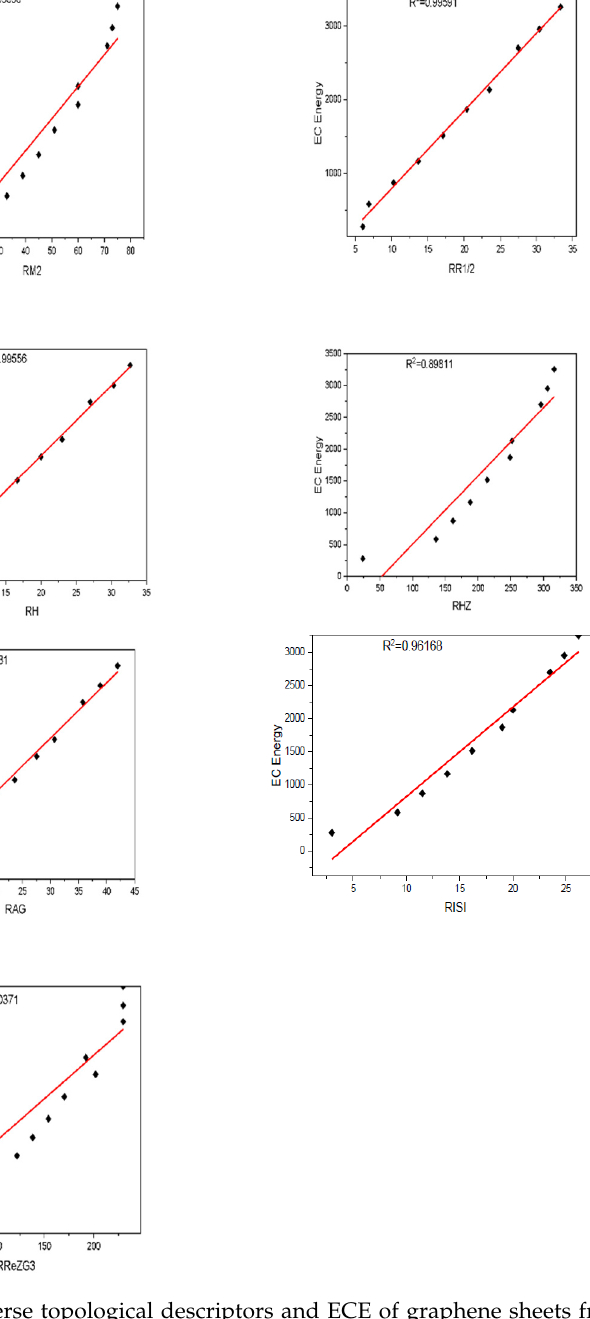
Figure 4. Predictive potential of the reverse topological descriptors via square of the correlation coefficient (𝑅 (cid:2870) ) .